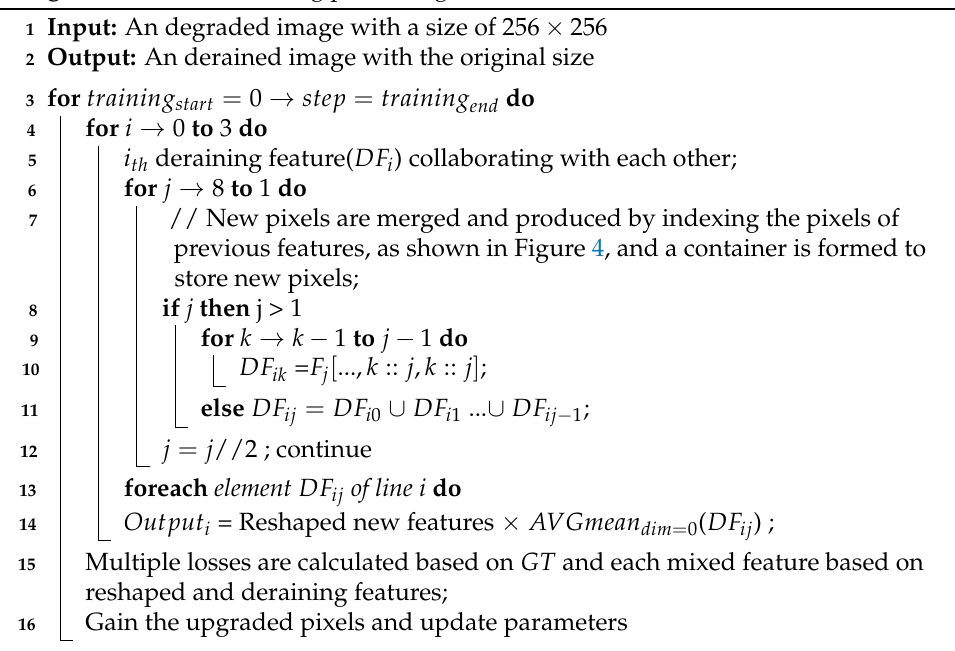
Algorithm 1: The deraining processing of